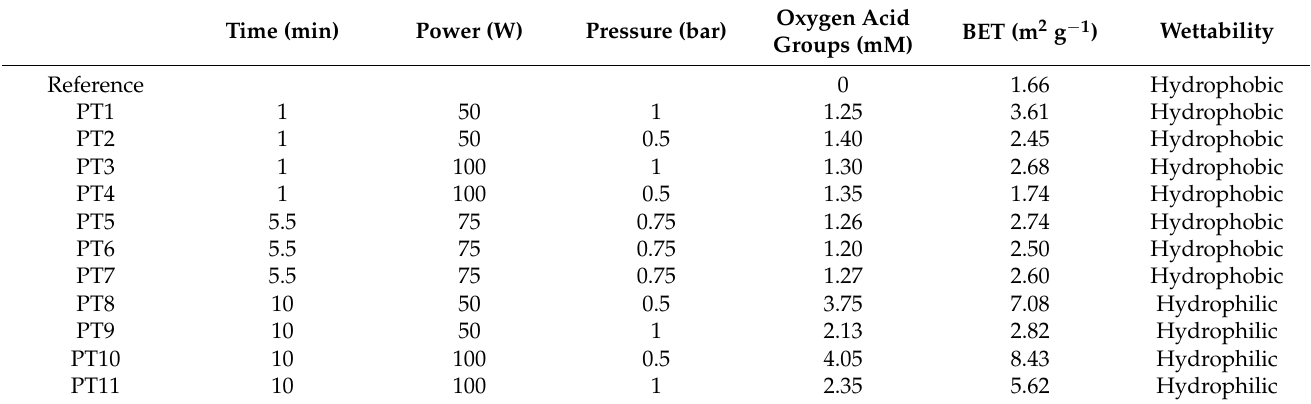
Table 3. Experimental conditions and parameters measured for plasma treatments.